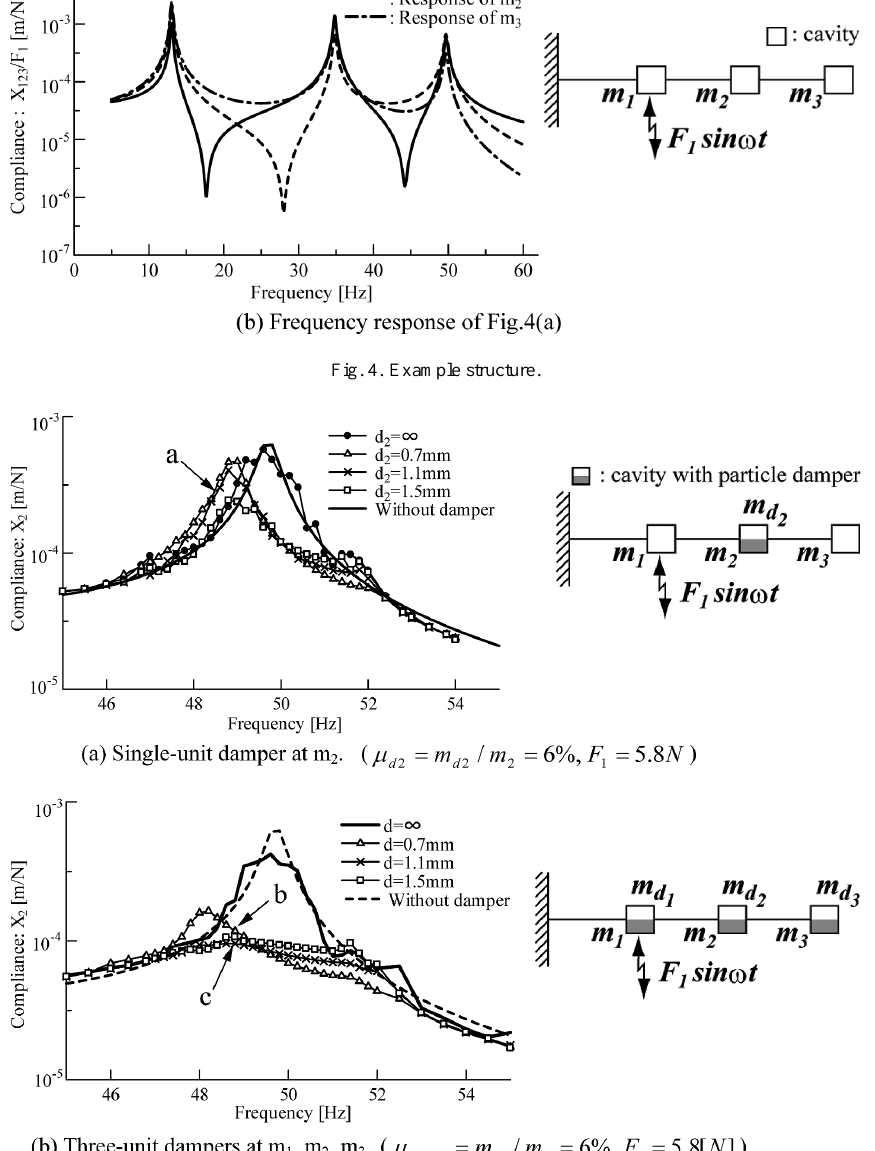
Fig. 5. Influence of the number of damper and clearance